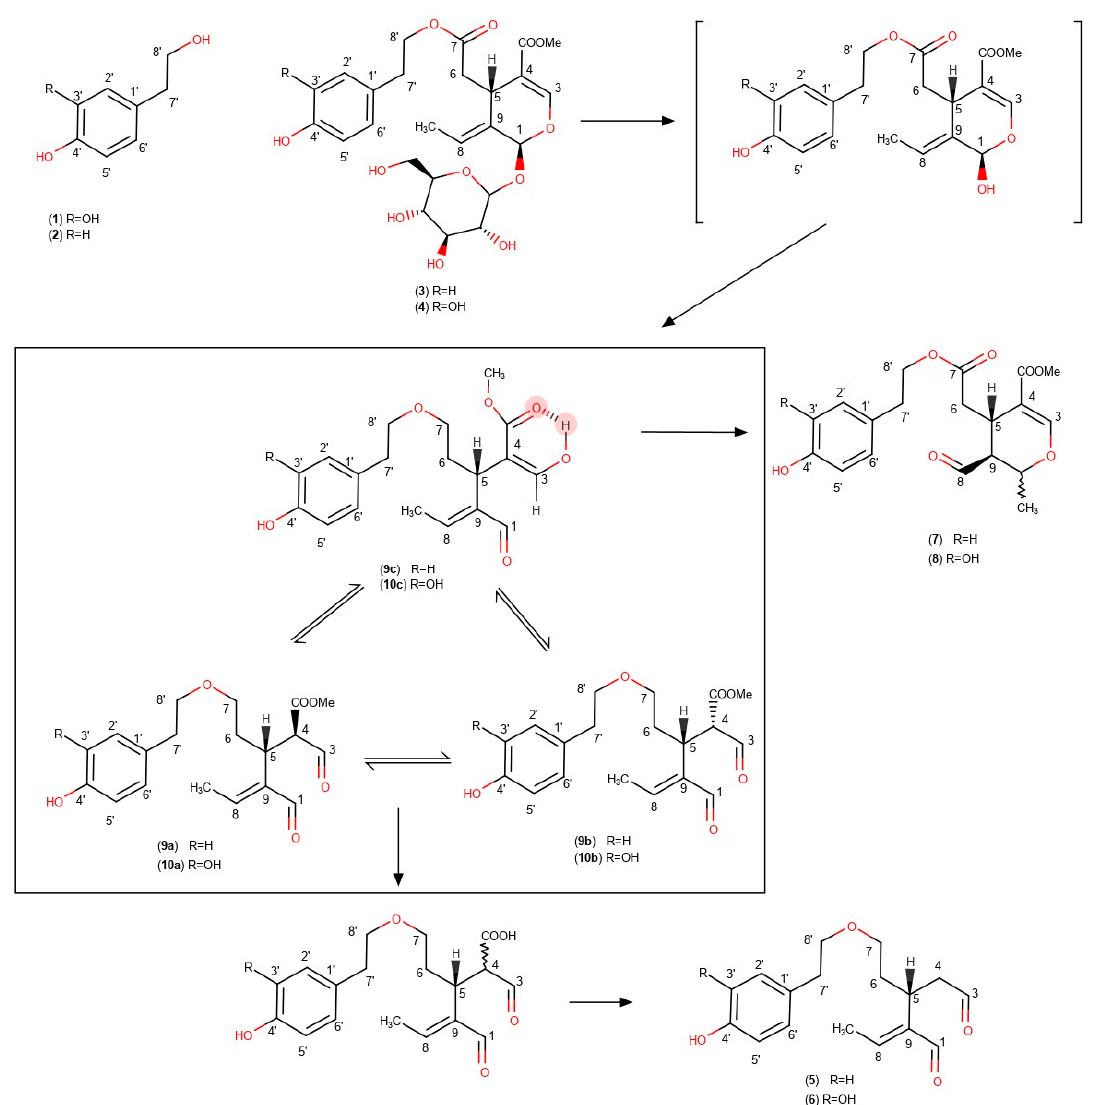
Figure 1. Proposed mechanism of oleocanthal ( 5 ) and oleacein ( 6 ) formation, starting from ligstroside ( 3 ) or oleuropein ( 4 ) through oleokoronal ( 9 ) or oleomissional ( 10 ). Hydroxytyrosol ( 1 ), tyrosol ( 2 ), ligstroside aglycon monoaldehydic form ( 7 ), and oleuropein aglycon monoaldehydic form ( 8 ) are also represented.